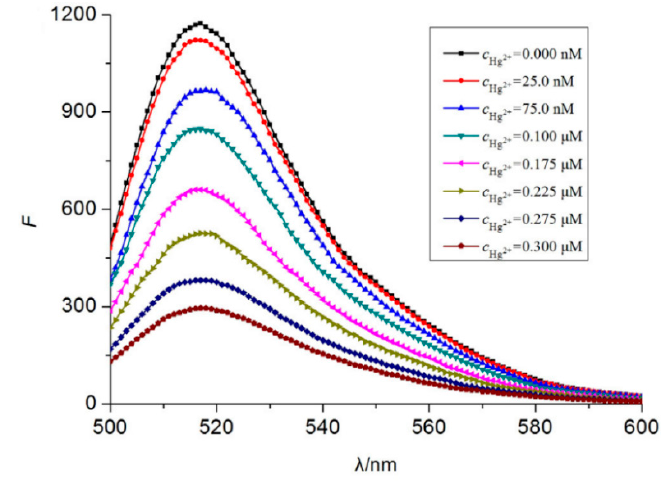
Figure 4. Fluorescence spectra of 5 (cid:48) -FAM-CGC TTG TTT GTT CGC ACC CGT TCT TTC TT-3 (cid:48) for different Hg 2+ concentrations. Reprinted with permission from [65].